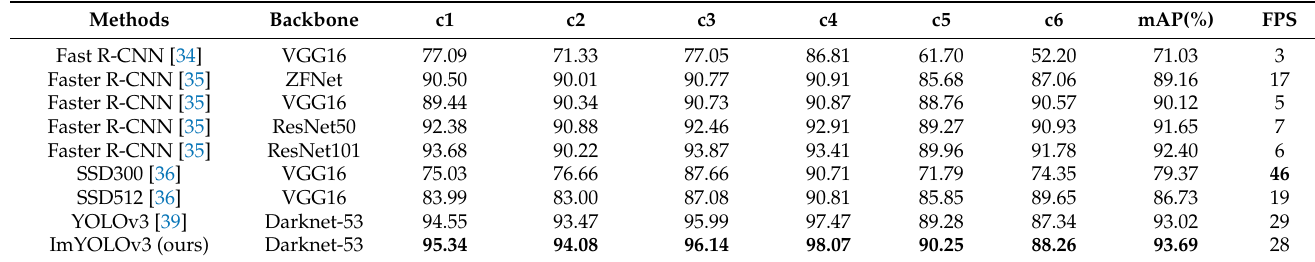
Table 5. Detection average precision (%) and speed of different methods on SeaShips. c1–c6 represent ore carrier, bulk cargo carrier, general cargo ship, container ship, fishing boat, and passenger ship, respectively. The entries with the best APs for each object category are